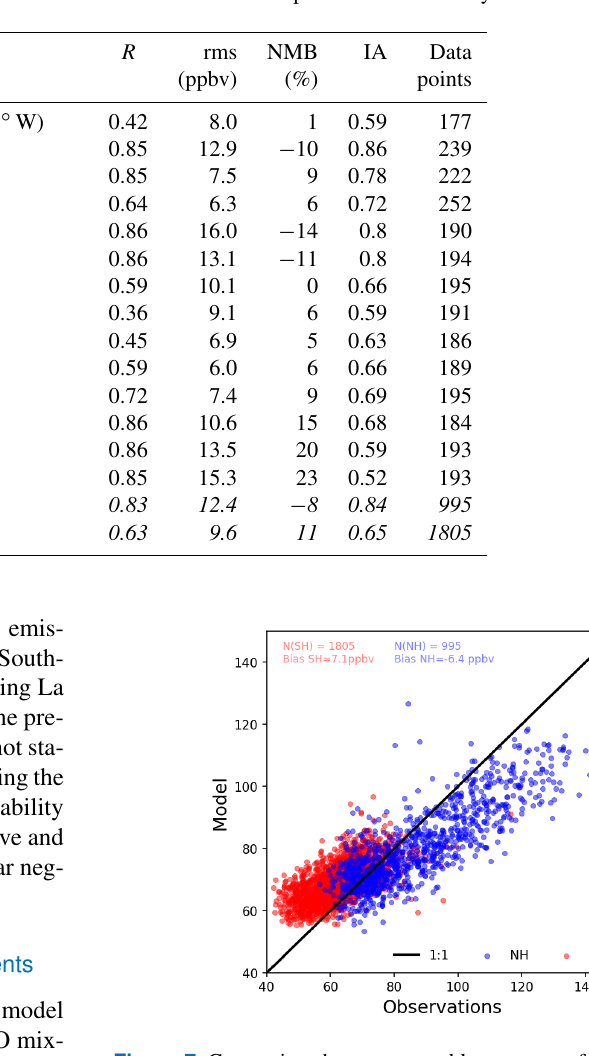
Figure 7. Comparison between monthly averages of simulated and observed surface CO at 14 stations in the Pacific (see Table 4). We show in red stations in the Southern Hemisphere (SH) and in blue stations in the Northern Hemisphere (NH). Also shown are the model bias over the SH and the NH and the number of data points considered. For reference, we draw the line 1 :